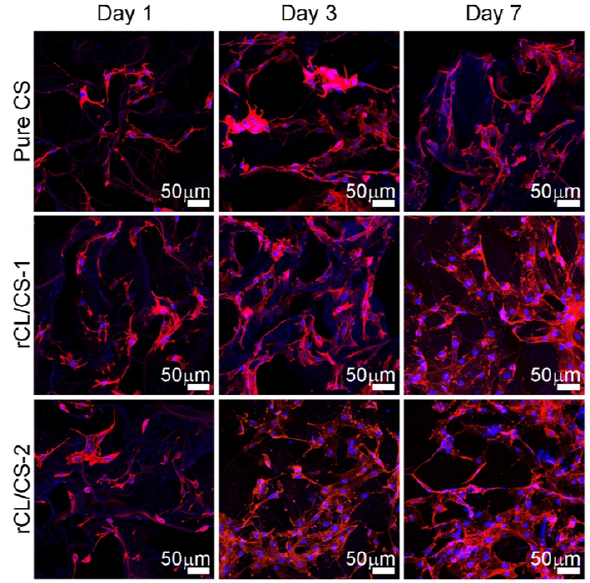
Figure 11. Confocal laser scanning microscopy (CLSM) microscopic images of MC3T3-E1 pre-osteoblast cells cultured on pure CS and rCL/CS hydrogel scaffolds. In the CLSM experiment, the density of MC3T3-E1 cells was maintained up to 3 × 10 4 cells/well. The CLSM imaging was performed on days 1, 3 and 7. In CLSM, the nucleus and cytoskeleton of the cell were stained with DAPI (blue) and rhodamine (red), respectively. Data reproduced from ref.